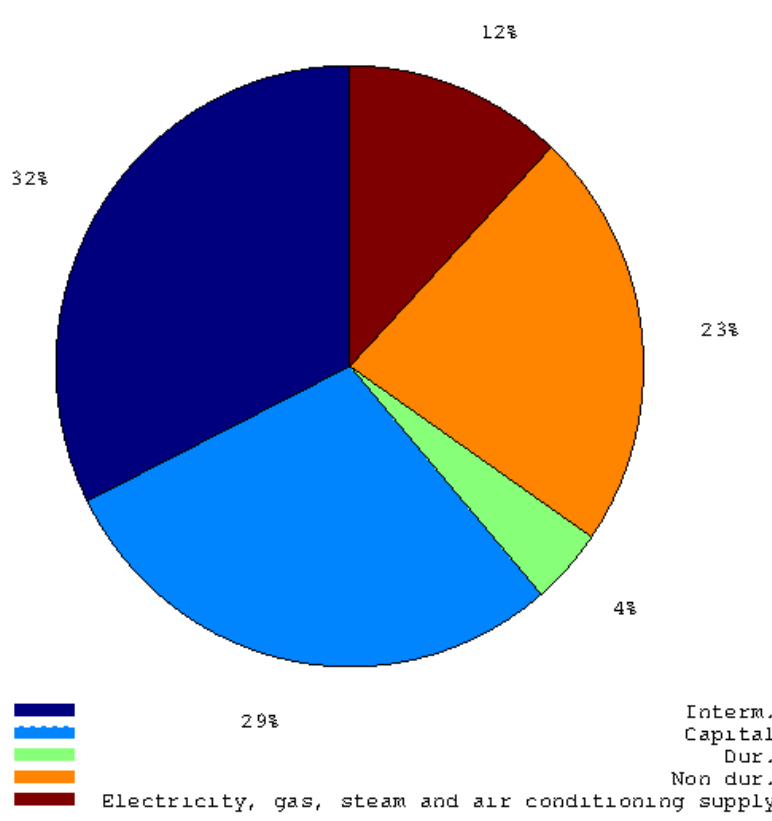
Figure 2. This pie graph shows the weights of main industry groupings in the Italian Industrial Production Index.